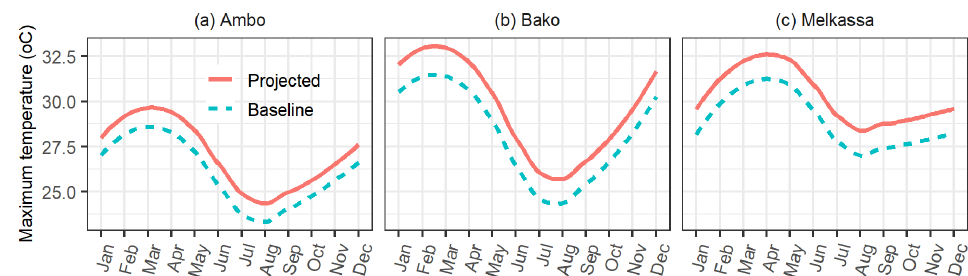
Figure 2. Multimodel ensemble average monthly maximum air temperature projected for 2030 compared to that observed (1995–2017) period for ( a ) Ambo (high altitude), ( b ) Bako (mid-altitude), and ( c ) Melkassa (low altitude).